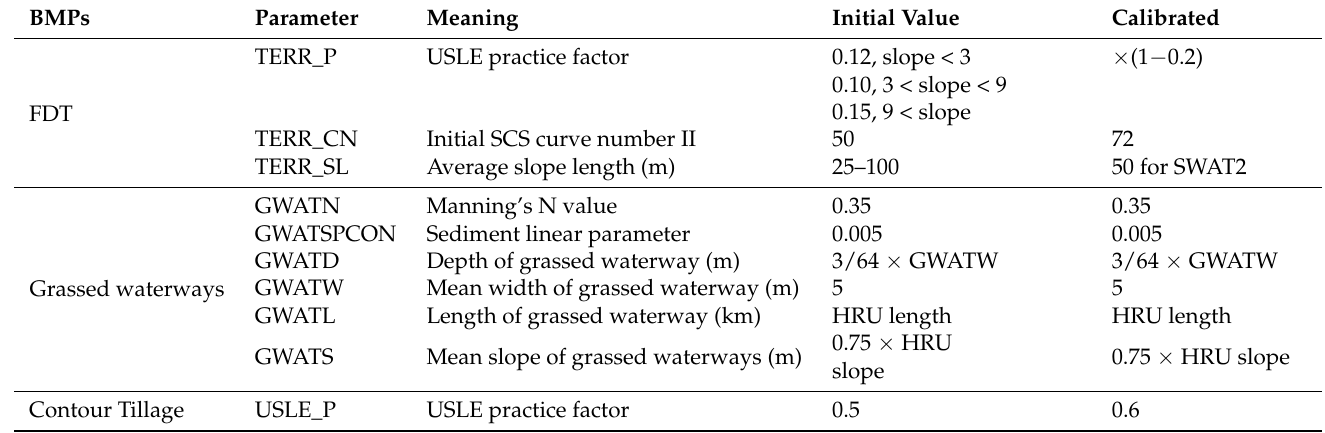
Table 3. Parameters of contour tillage, FDT, and grassed waterways adjusted for SWAT1 and